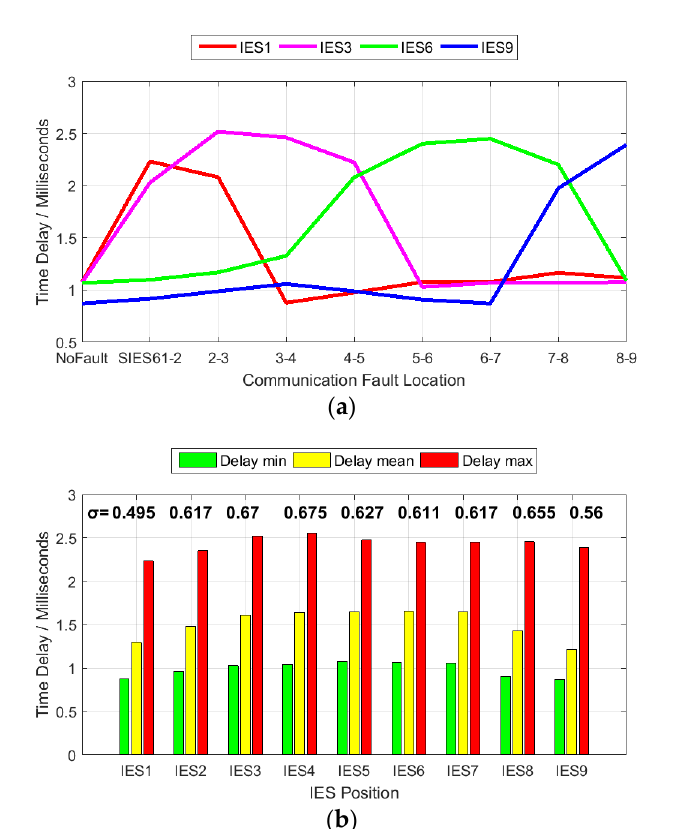
Figure 9. The time delay evaluation: ( a ) the time delay under different communication network topologies and ( b ) the time delay of each IES.